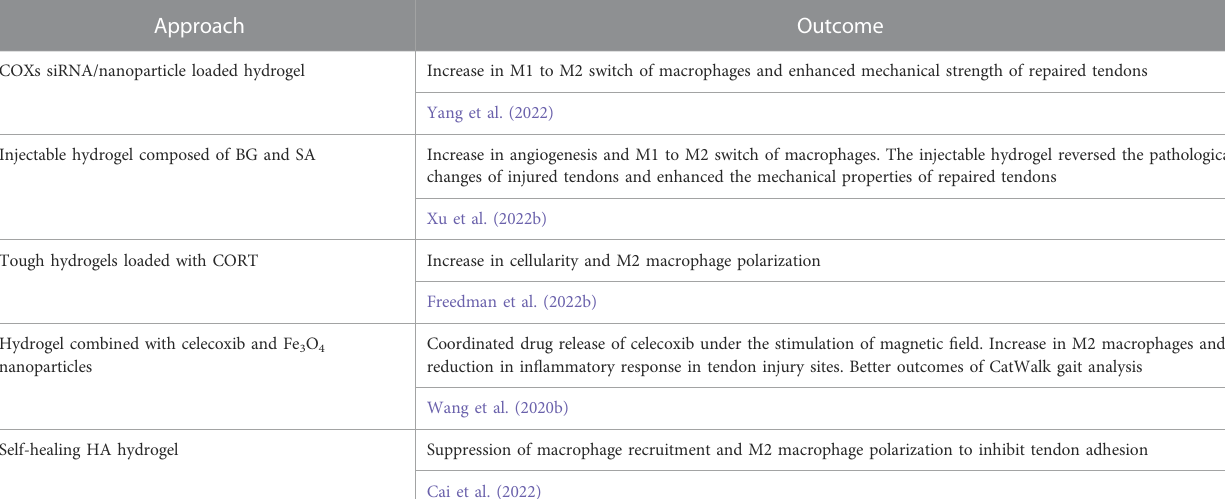
TABLE 3 The effect of immunomodulatory hydrogels on macrophage regulation in tendon repair.